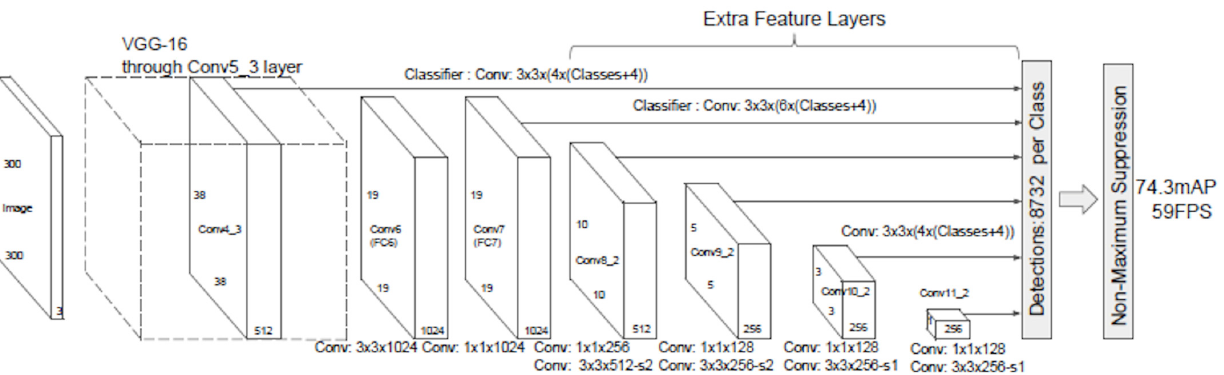
Figure 6. MobileNet-SSD architecture [24].